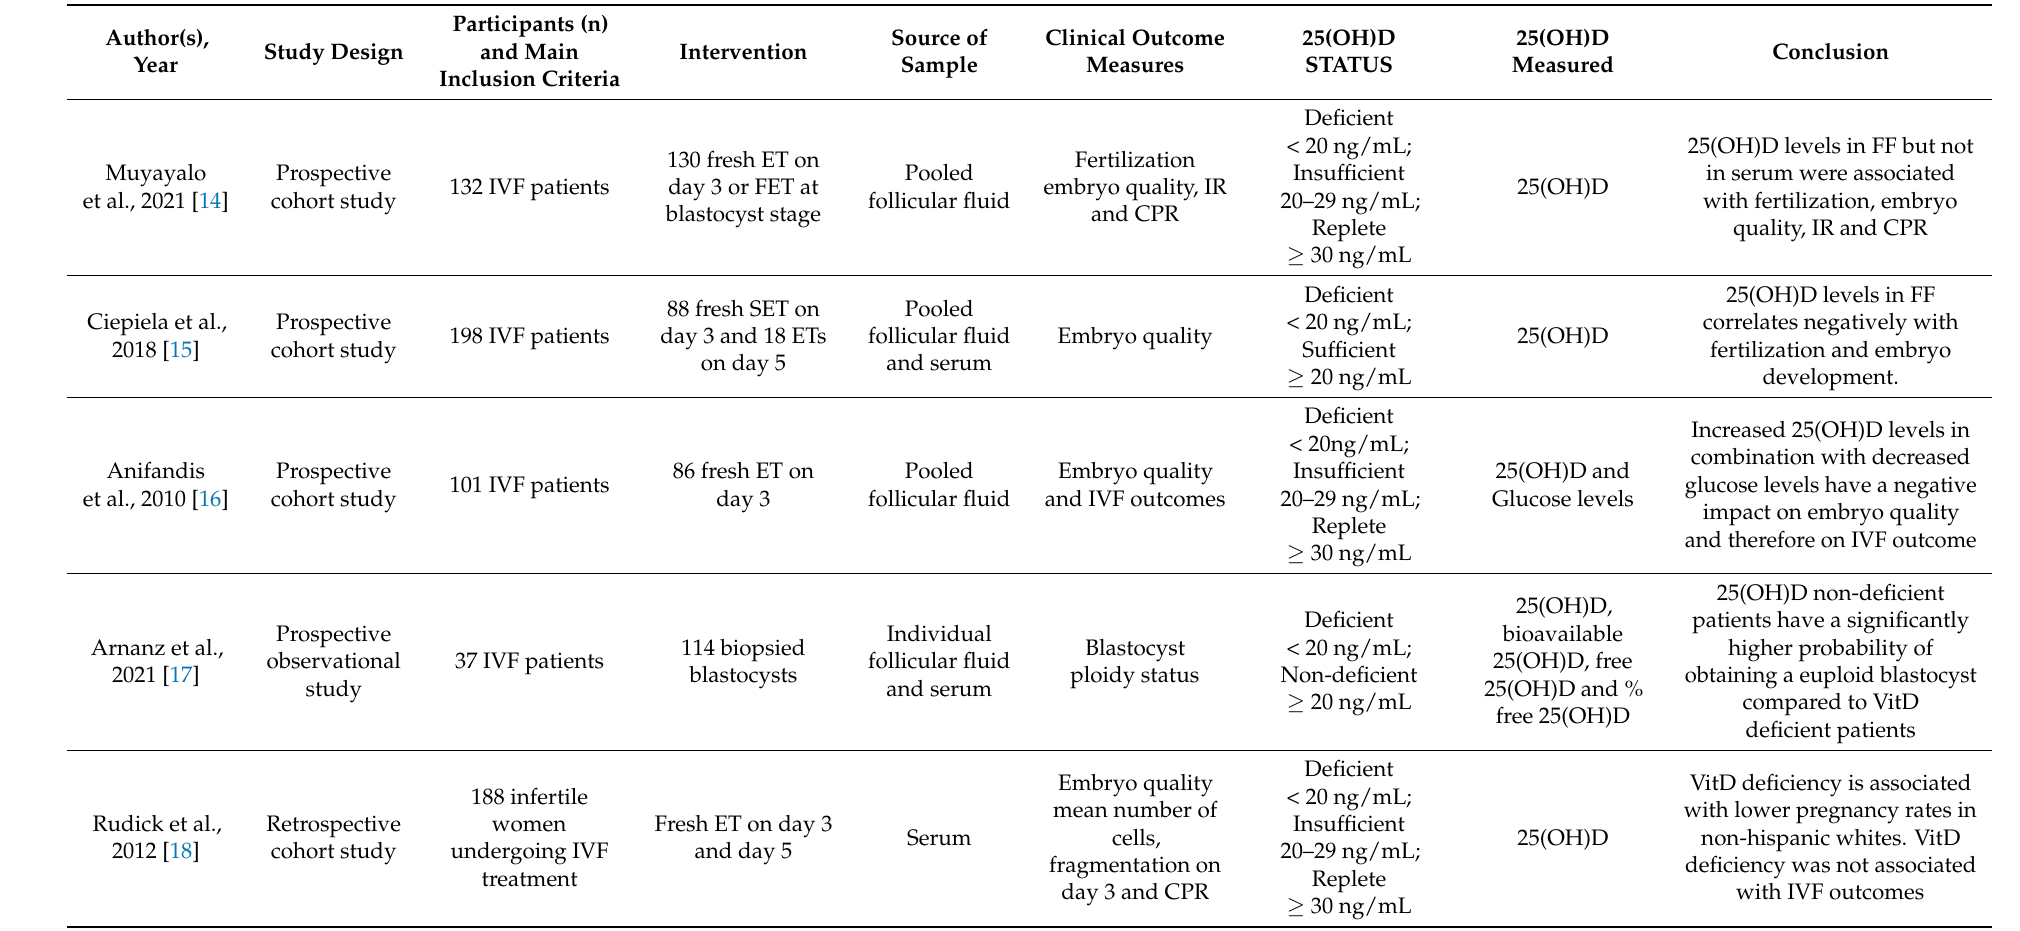
Table 1. Characteristics of the studies regarding 25(OH)D and embryo development/implantation/clinical pregnancy/live birth rate after IVF/CSI included in the